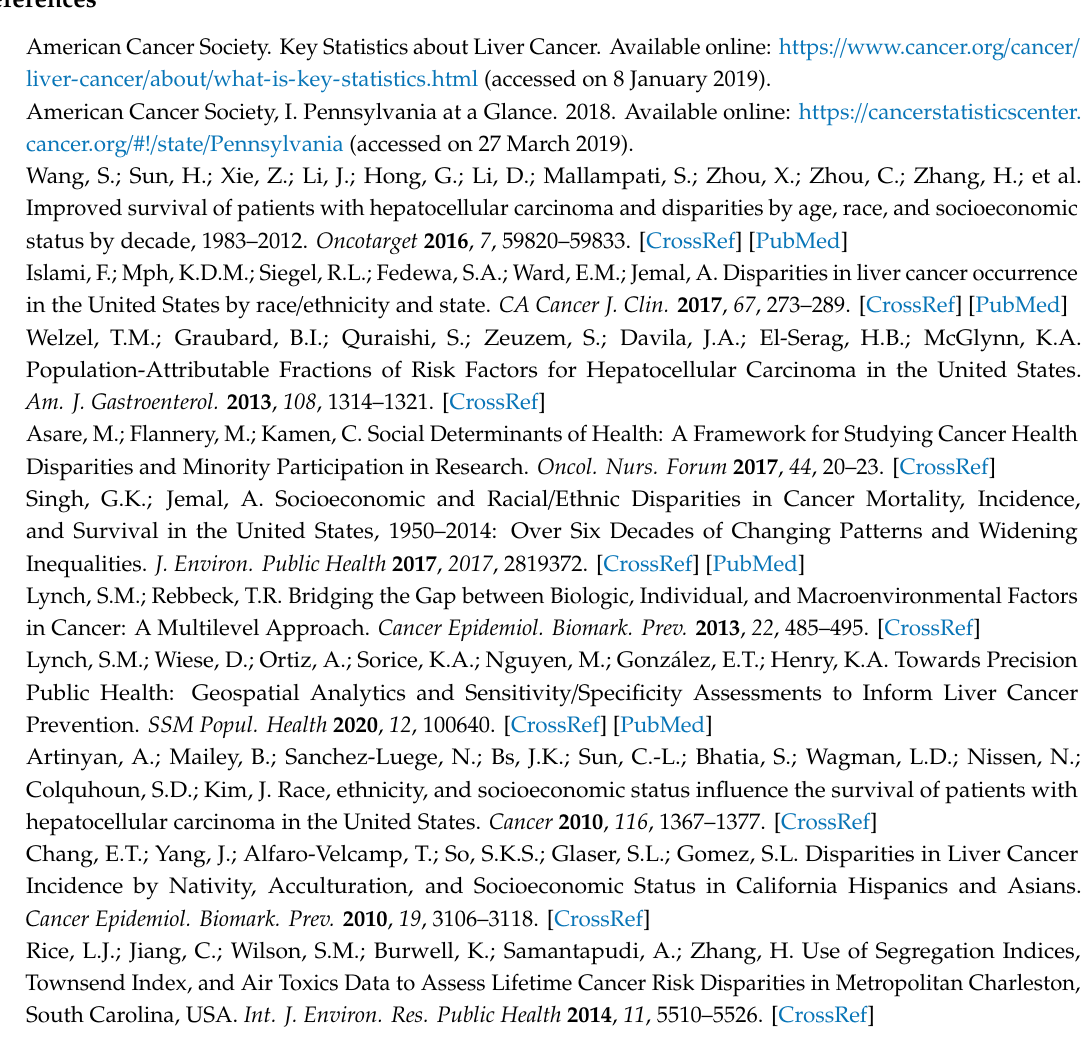
Figure S1: Pearson Correlation and Scatter Plots for Each Neighborhood Socioeconomic Measures (nSES), Figure S2: Spatial Variation Across Neighborhoods socioeconomic measures (nSES): Comparison of Discrepancies between neighborhood Census Tract identified in the highest quartile of poverty (“high poverty”) vs the highest quartile of the each nSES measure (“high deprivation”), Figures S3–S15: Relative Risk Estimates for Liver Cancer by Census Tract Maps, TableS1: Model Characteristics Comparing Model Fit (DIC), Relative Risk Range (RR) and Unexplained Geographic Disparity (GD)